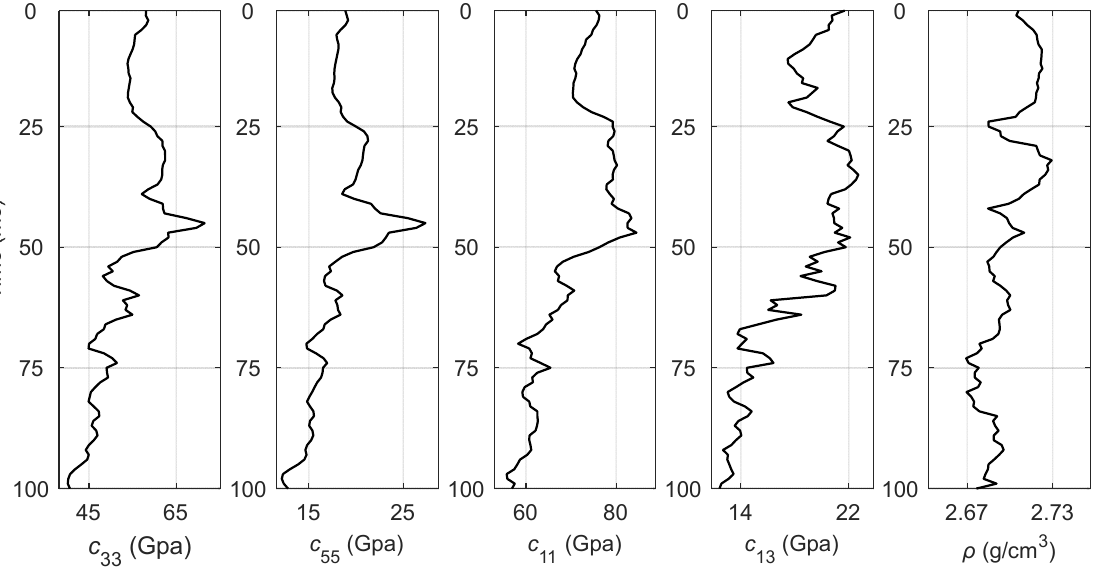
Figure 2. Well model for the synthetic data test. The panels from left to right give the true values of the elastic sti ff ness parameters of c 33 , c 55 , c 11 , c 13 , and density ρ .